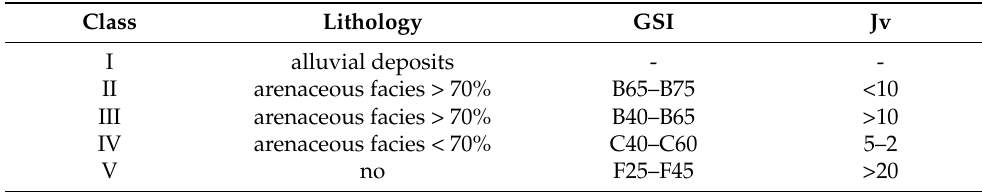
Table 1. Geomechanical classification of the rock mass outcropping in the slopes surrounding the Lake Campotosto basin.